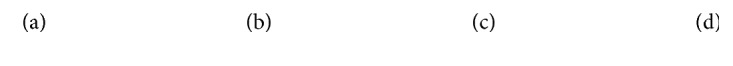
Effect of Rhus verniciflua extract (RVE) on the Ag/IgE-induced passive cutaneous anaphylaxis (PCA) model. ICR mice were subcutaneously injected with DNP-IgE (4 μg/mL) into the ear. After 24 h, mice were orally administered with RVE (250 or 500 mg/mL) and dexamethasone (10 mg/mL). After 1 h, DNP–HSA (300 μg/mL) containing 1% Evans blue was intravenously injected into their tail veins for 1 h The extravasated dye in the ears was analyzed using the procedure described in the Materials and Methods section. Results are expressed as mean ± SE of at least five independent experimental results that were tested by analysis of variance with Bonferroni's post hoc testing; ###p < 0.0005 versus the control group; ∗∗∗p < 0.0005 versus the DNP-Ag-treated group.